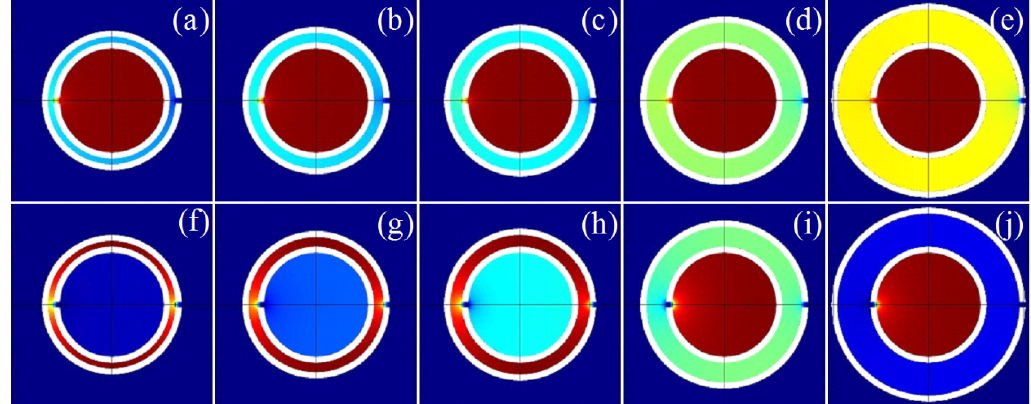
Figure 11. The energy distributions of TLSHSs at the resonant frequencies of ( a ) 795, ( b ) 780, ( c ) 765, ( d ) 655, ( e ) 550, ( f ) 2510, ( g ) 2185, ( h ) 2014, ( i ) 1630, and ( j ) 1432 Hz.